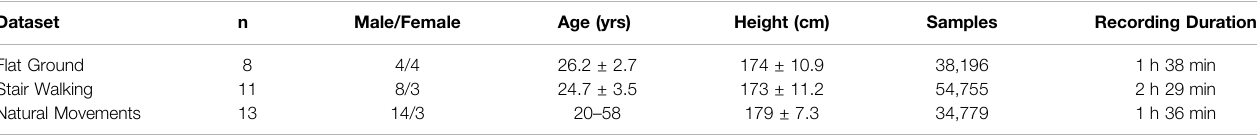
TABLE 1| Details ofthetraining dataset used inthisstudy. Additional individuals were heldout forafuture testing dataset. Sampledduration re fl ects thecombined lengthof the recordings from which samples were uniformly extracted.